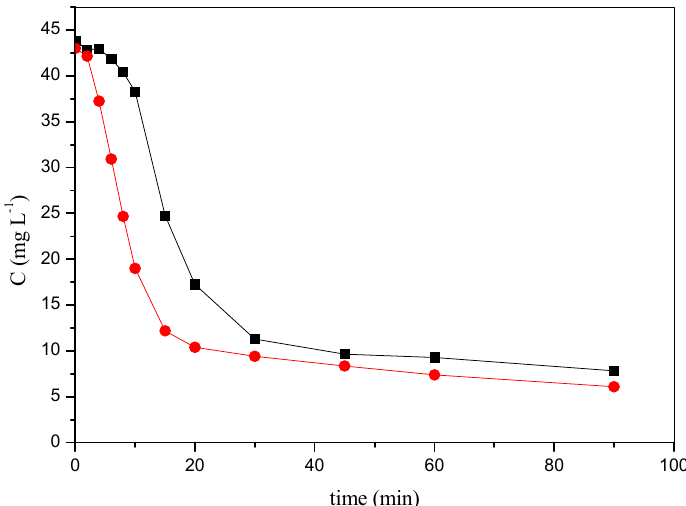
Figure 3. Photocatalytic degradation of 40 mg L − 1 CLPR with photo ‐ Fenton reagent in the presence of 7 mg L − 1 Fe 3+ and 100 mg L − 1 H 2 O 2 at pH: 3.0: ( ■ ) visible and ( ● ) UV ‐ A radiation.